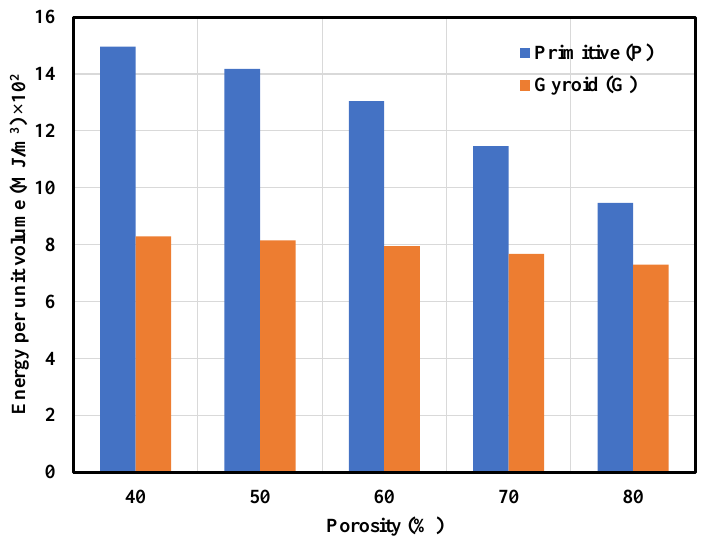
Figure A4. Summary of SEA results for P and G lattice structures based on different porosities ranging from 40% to 80%.